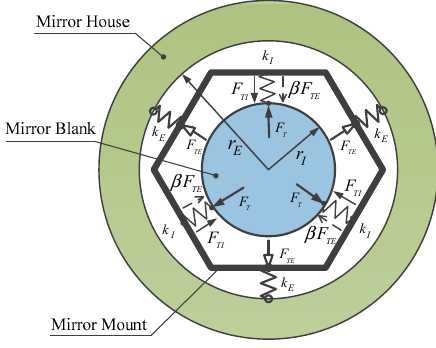
Figure 2. Illustration of TCML acting on the mirror.